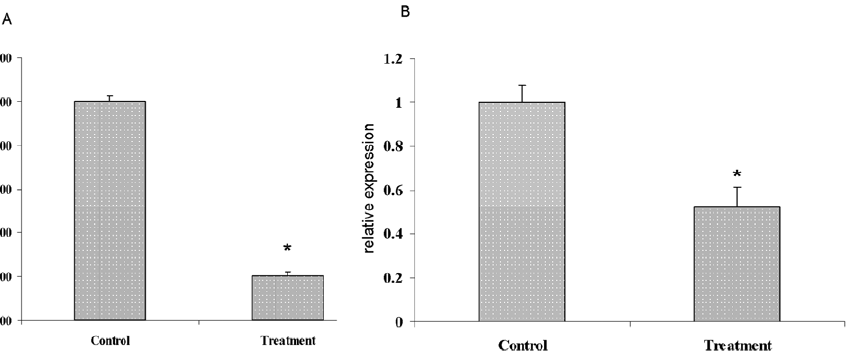
Figure 1. Serum T4 levels and liver malic enzyme mRNA levels in mouse pups rendered hypothyroid by 3 day exposure of dams and their litters to drinking water containing MMI and perchlorate from PND 12 to 15. A. Serum T4 data are expressed as mean 6 standard error (SE, n=10) and * indicates significant difference (p , 0.001). B. qRT-PCR for malic enzyme mRNA (positively regulated by direct TH action) was performed with RNA derived from male pups. Data are presented as mean 6 SE (n=5). A two-tailed Student’s t-test was used to calculate significance and * indicates p=0.03.